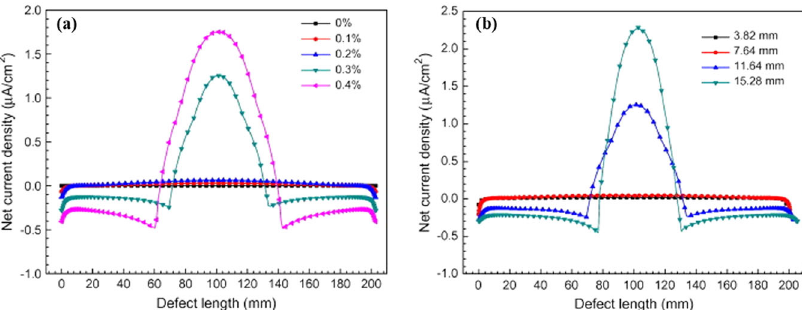
Fig. 4 Distribution of anodic current density along the bottom of corrosion defect. a Under different longitudinal tensile strains. b Under different corrosion depths 62 . Reproduced with permission from ref. 62 , copyright (Elsevier,